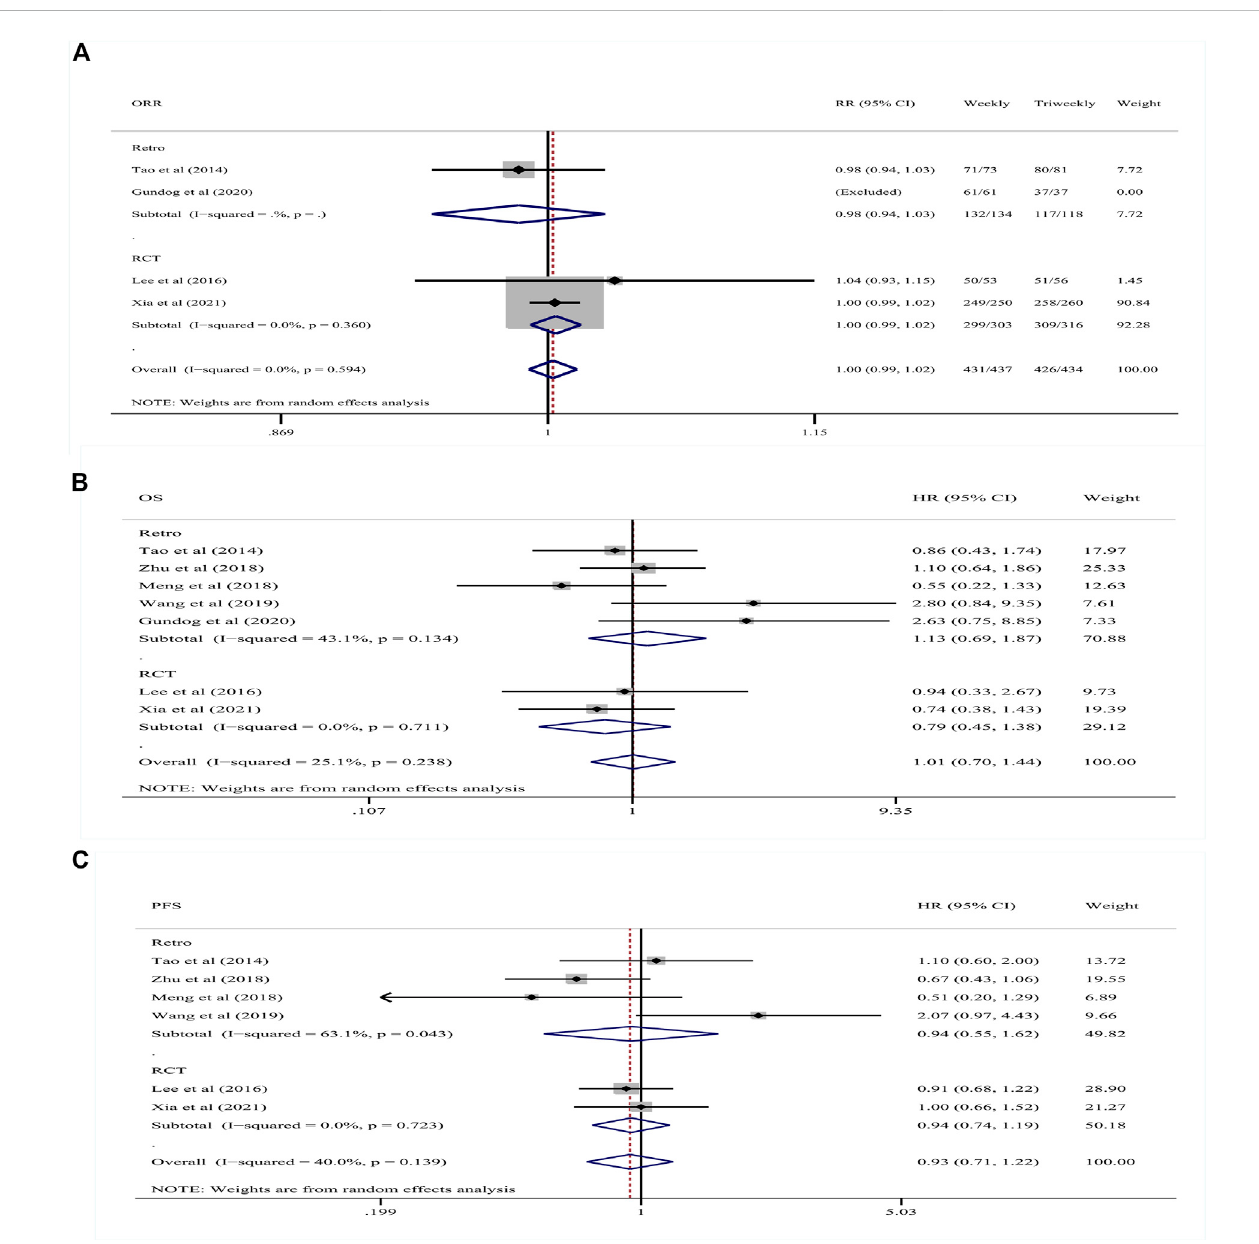
FIGURE 2 Forestplotsofthecomparisonof (A) ORR; (B) OS,and (C) PFSbetweenpatientsadministeredcisplatinweeklyortriweekly.ORR,objectiveresponserate; OS, overall survival; PFS, progression-free